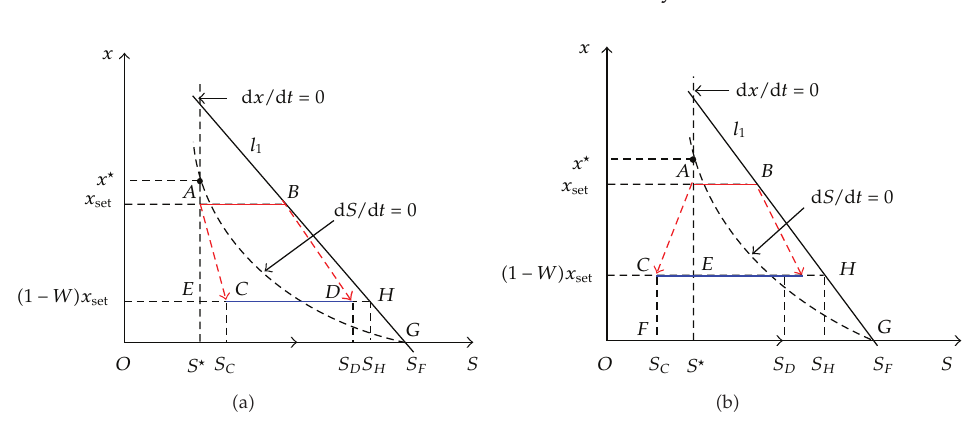
Figure 3: Illustration of system (cid:5) 2.6 (cid:6) (cid:5) a (cid:6) S C ≥ S (cid:2) ; (cid:5) b (cid:6) S C < S (cid:2)